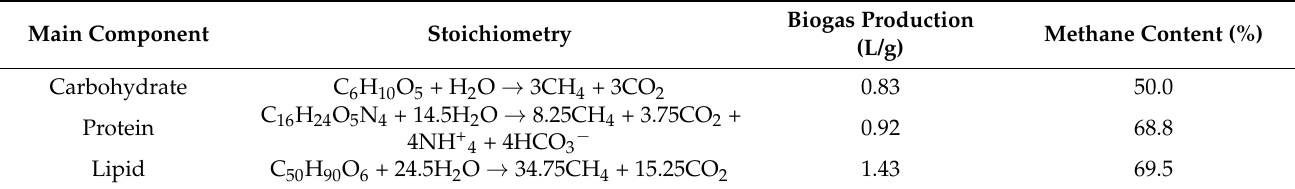
Table A1. Stoichiometry balance for POME in anaerobic digestion [20]. Main Component Stoichiometry